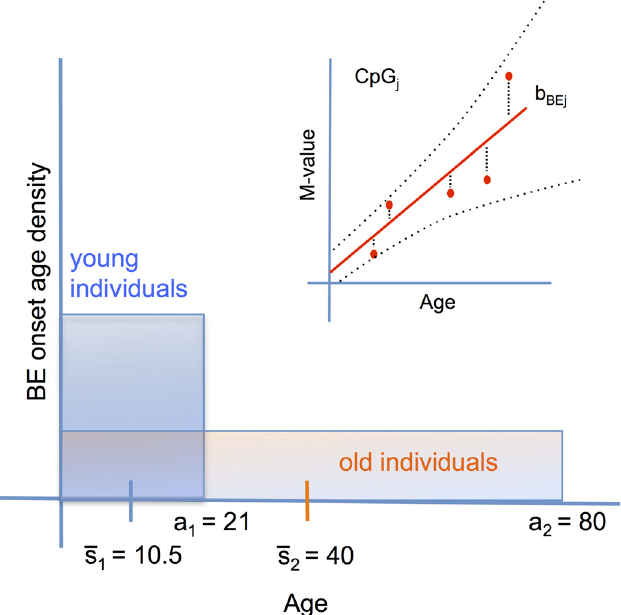
Fig 2. Population drift from set D2. The heterogeneity with age around the mean population drift rate may be caused by the inter-individual heterogeneity of BE onset times from a tissue of origin. Illustration of cross- sectional BE data for a certain CpG j is shown in upper right inset with mean population rate b BEj . Due to lack of data on onset age, we assume a priori uniform, flat distributions for BE onset times. Thus, two example patients from data set D2, who had biopsies taken at index endoscopy ages a 1 = 21 and a 2 = 80, would have mean BE onset times (cid:1) s 1 ¼ a 1 = 2 ¼ 10 : 5 and (cid:1) s 2 ¼ a 2 = 2 ¼ 40 , respectively. Older patients diagnosed with BE are expected to show greater mean and variance in BE onset ages compared to younger